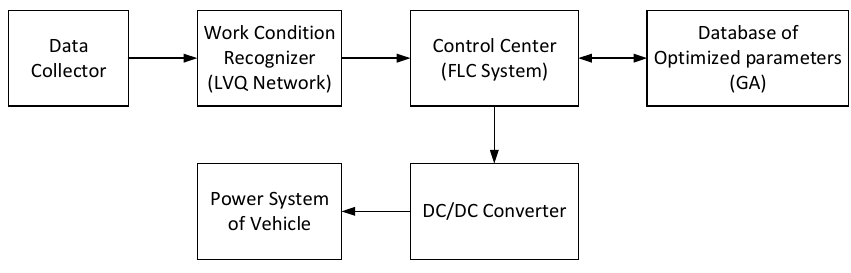
Figure 6. The main structure of the optimization strategy [23].